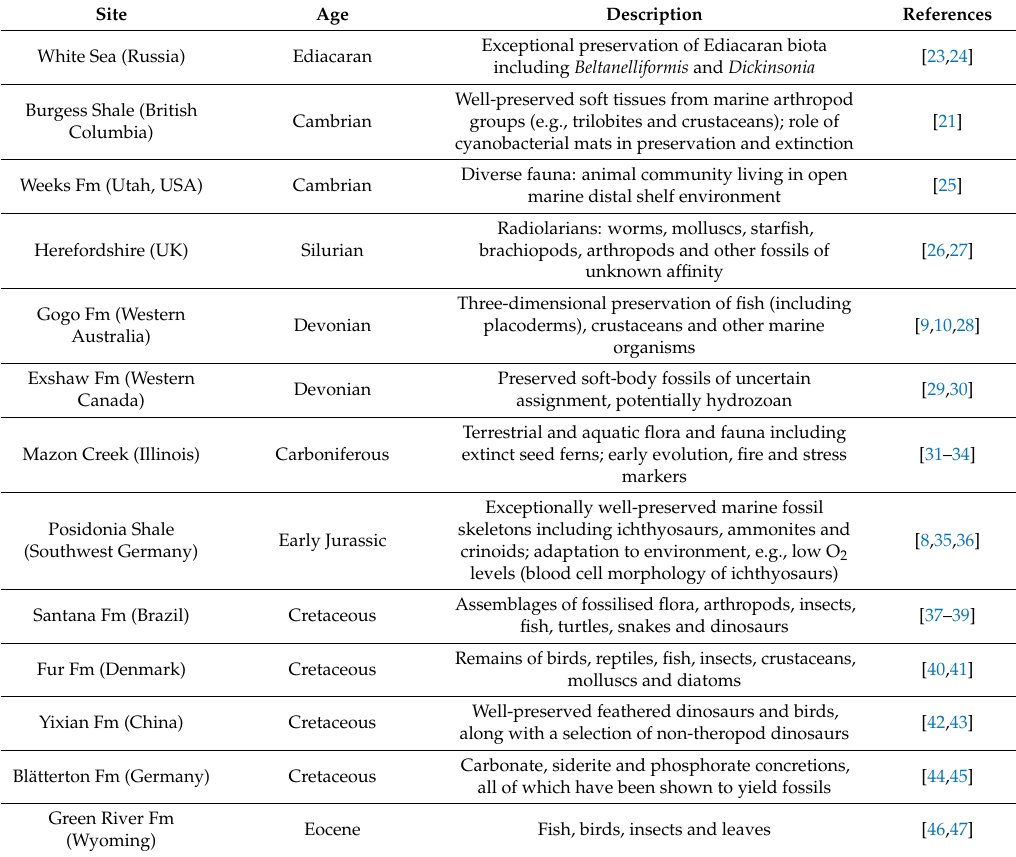
Table 1. The locations of notable Konservat-Lagerstätten and Konzentrat-Lagerstätten samples.